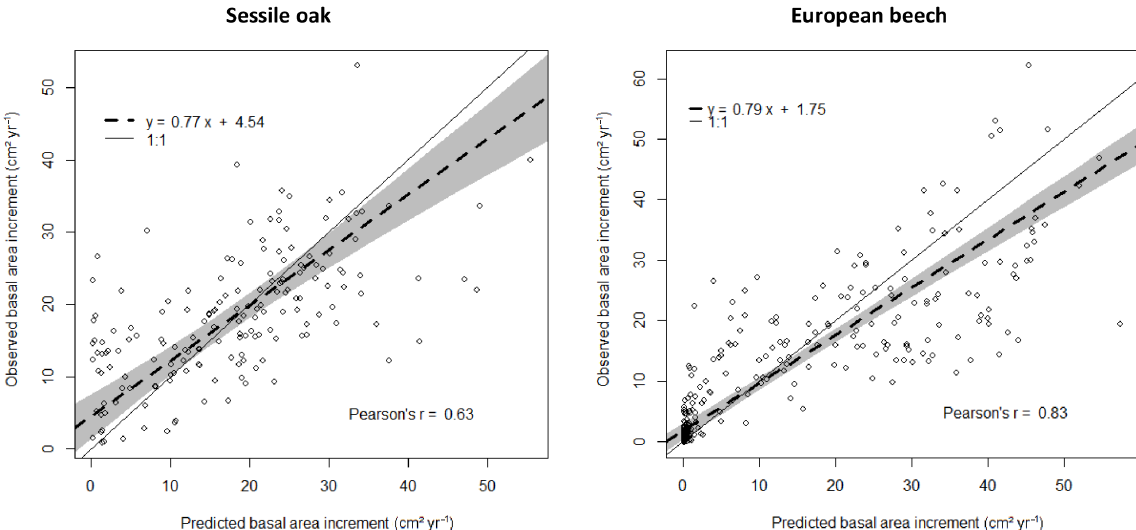
Figure 3. Comparison of observed and predicted basal area increments (BAIs) for the simulation with the photosynthesis method of CAS- TANEA, the npp to gpp ratio approach to account for tree respiration and the distance-dependent crown extension (see Table 3). The dashed line represents the Deming regression between observations and predictions, with the shaded area indicating the 95% confidence interval and the solid line the 1:1